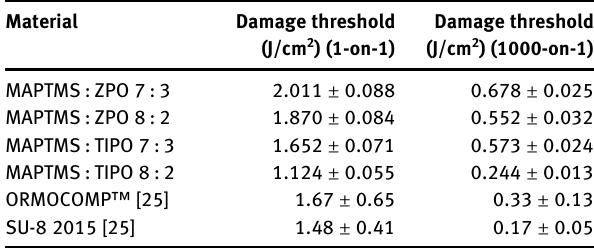
Table  : fs LIDT characterization. Material Damage threshold Damage